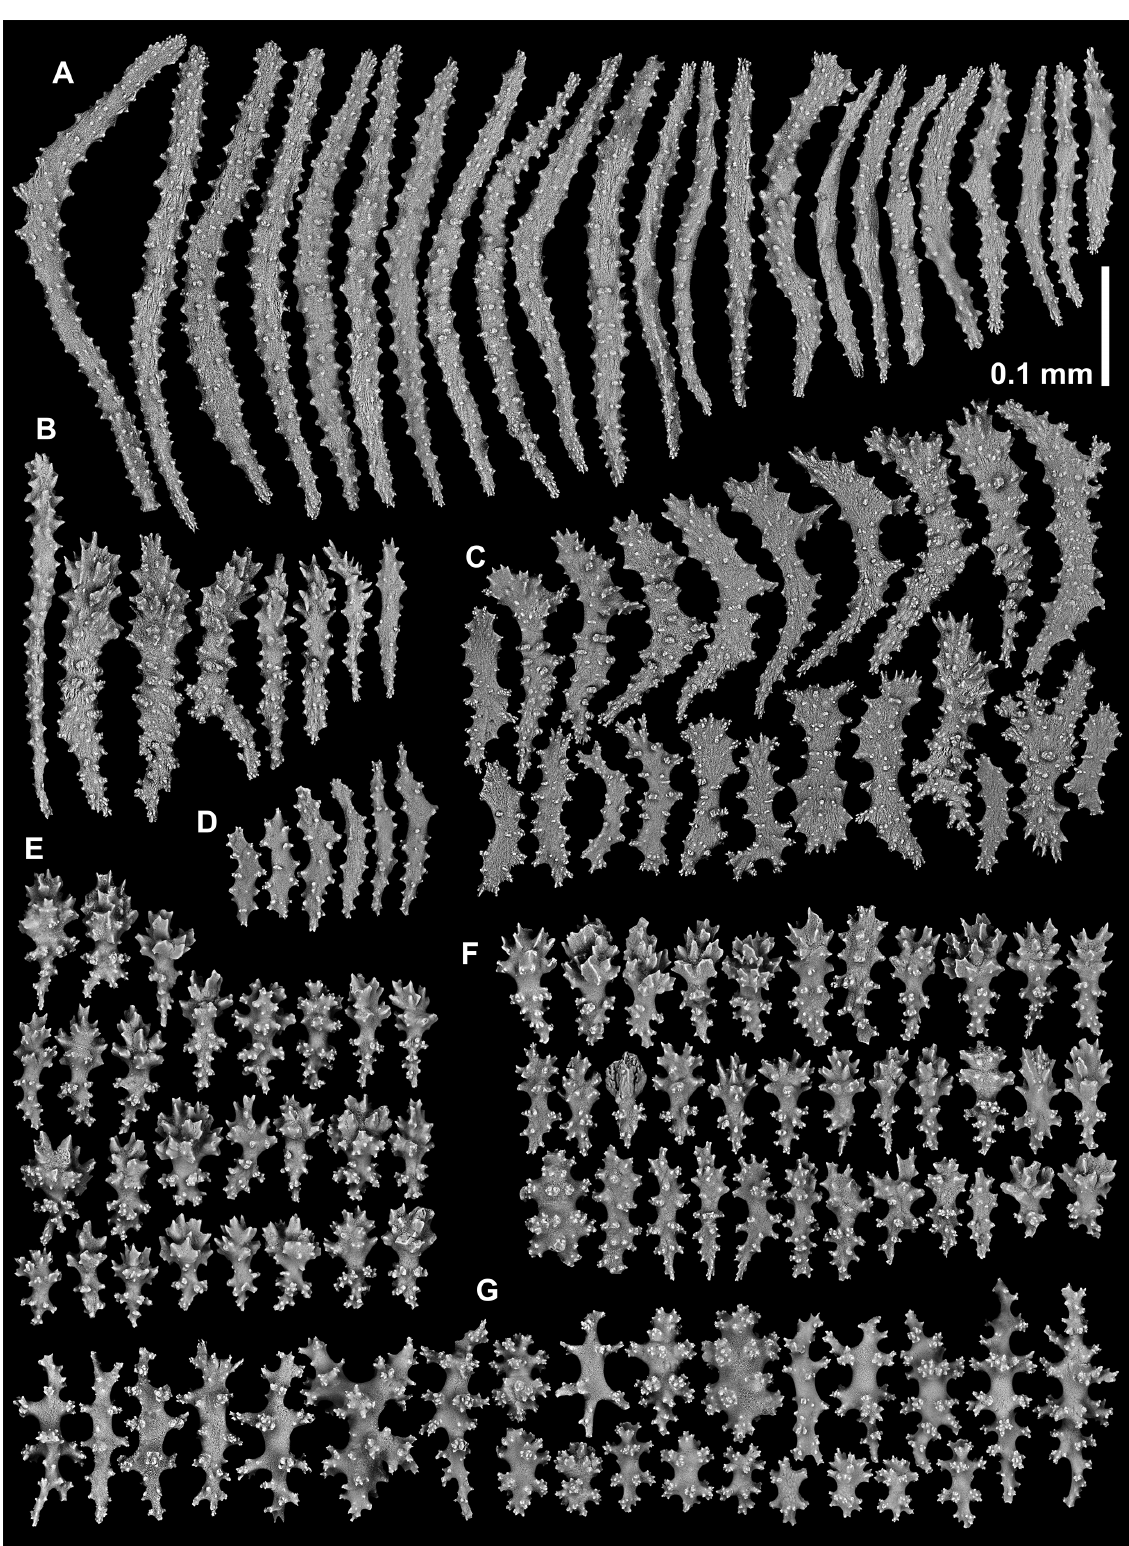
Fig. 5. Kotatea amicispongia gen. et sp. nov., holotype (NIWA 156312), SEMs of sclerites. A . Collaret and points. B . Distal points. C . Tentacles. D . Polyp neck. E . Polyp mound. F . Lobe surface. G . Lobe